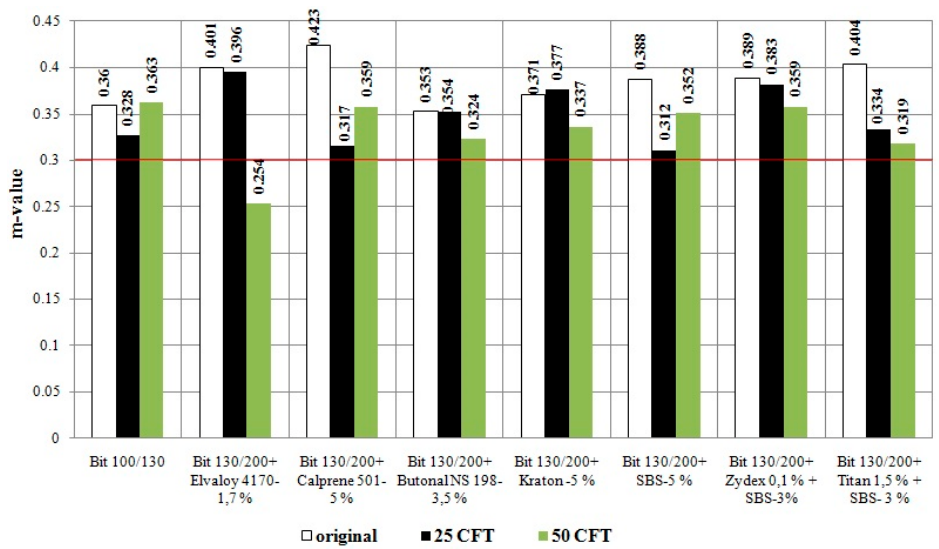
Figure 11. Bitumens m-value at the temperature of –30° С .